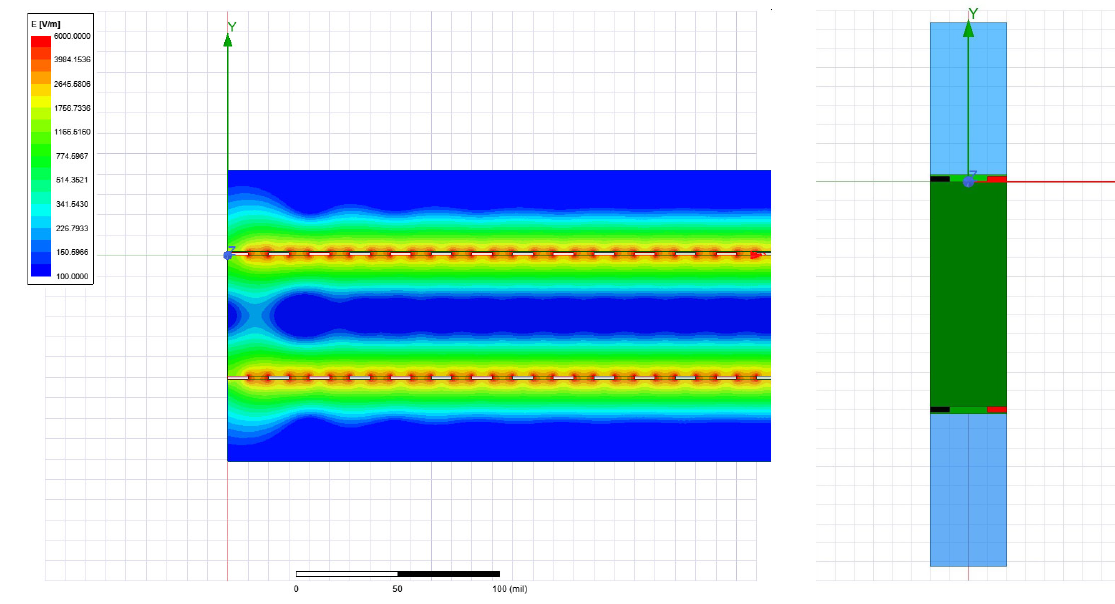
Figure 6. Full and reduced 2D simulation setup from ANSYS Q3D